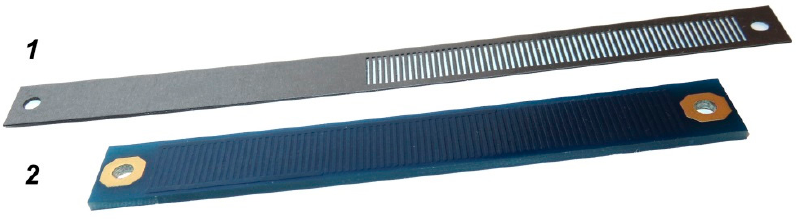
Figure 6. Measurement scales used for the simulation and the characterization of the microsystem. 1—transformer steel laser cut scale with 0.35 mm thickness; 2—PCB scale with 35 µm copper thickness. Full and void parts of the scale are each 0.5 mm wide, resulting in a scale period of 1 mm.